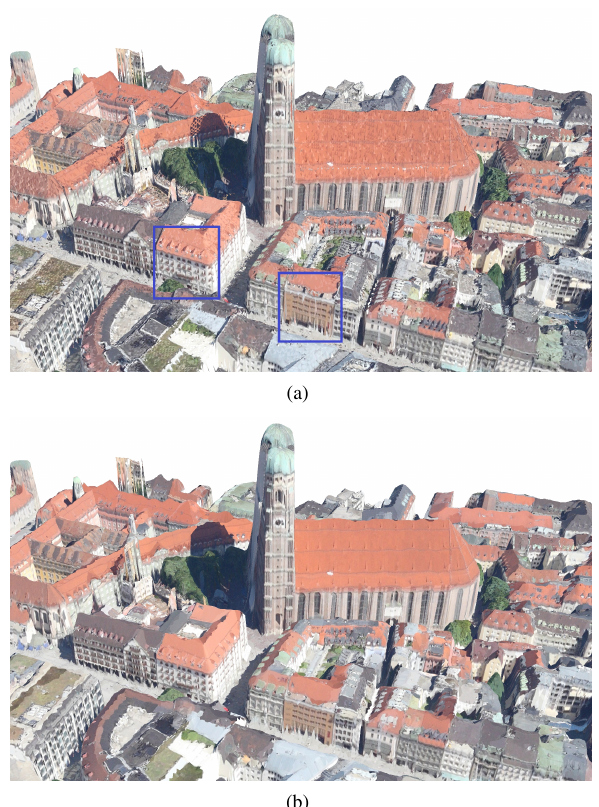
Figure 7. Textured inner city Munich model. (a) Textured city model for λ = 0.0. (b) Textured city model for λ = 0.5 ( α - expansion algorithm, T =